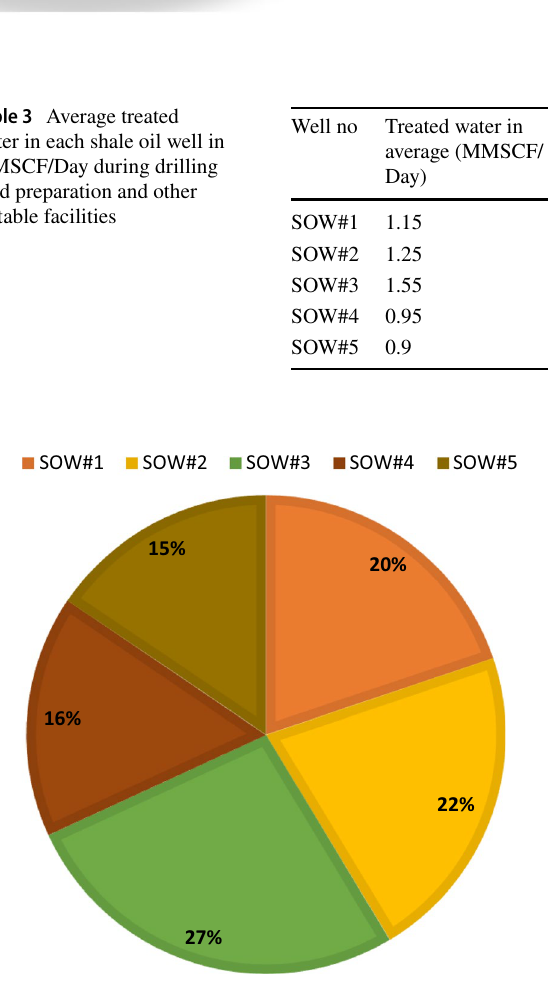
Fig. 3 Treated wastewater for each shale oil well during drilling mud preparation and other well